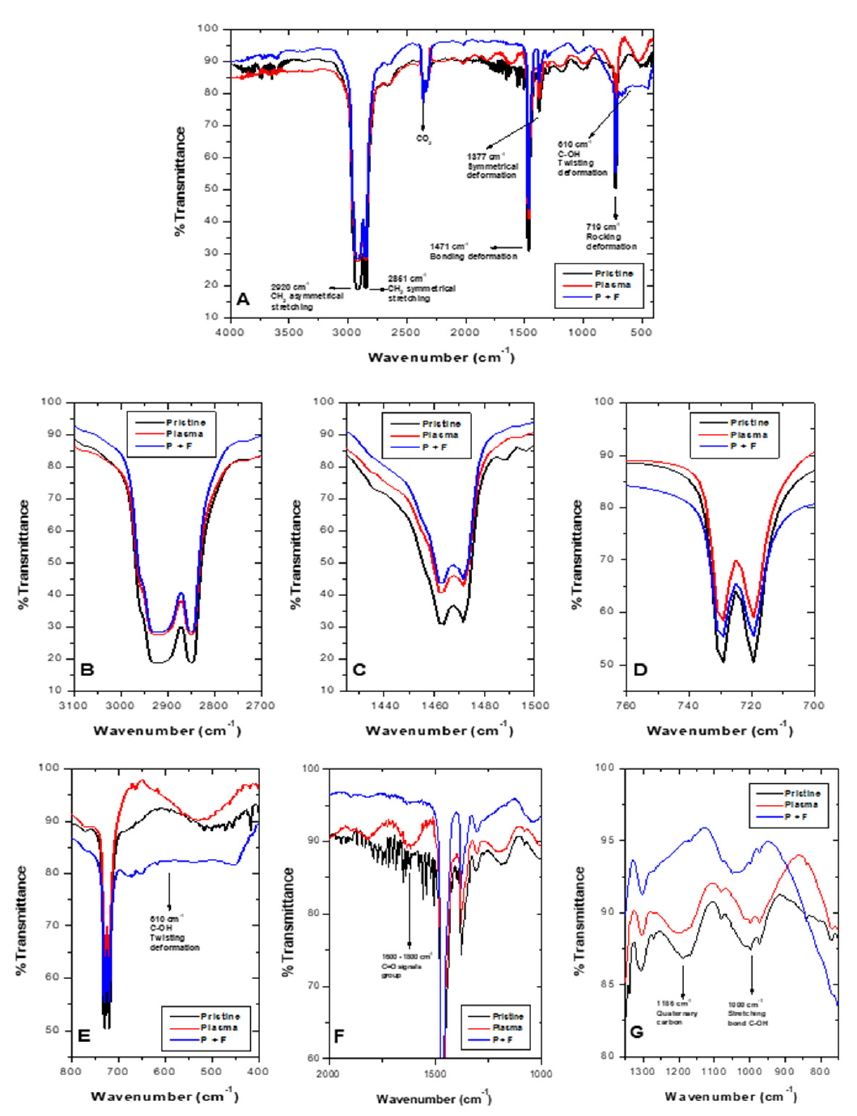
Figure 8. FTIR spectra for untreated and treated LDPE sheets. Pristine LDPE (black line), post-plasma (red line), and after sequential plasma and photocatalysis (blue line). ( A – D ) Regions characteristic of LDPE, where after the treatments, a decrease in signal appeared. ( E – G ) Regions where changes after the sequential process occurred. LDPE SEM images obtained from the 2 2 factorial design are depicted in Figure 9, without analysis (9A) and analyzed through image processing (9B). It can be observed that treatment T1 (pH 4.5 ± 0.2 and 1 gL − 1 TiO 2 ) (Figure 9B,E) resulted in the highest surface modification (cavity appearance) of 8.86% (Figure 9B’) and 11.94% (Figure 9E’) for the same treatment at 400 h. Table 2 shows the response variables during sequential